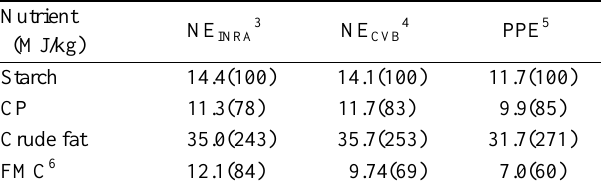
Table 5. Energy values of digestible nutrients relative to starch in NE systems and the potential physiological energy (PPE) system 1,2